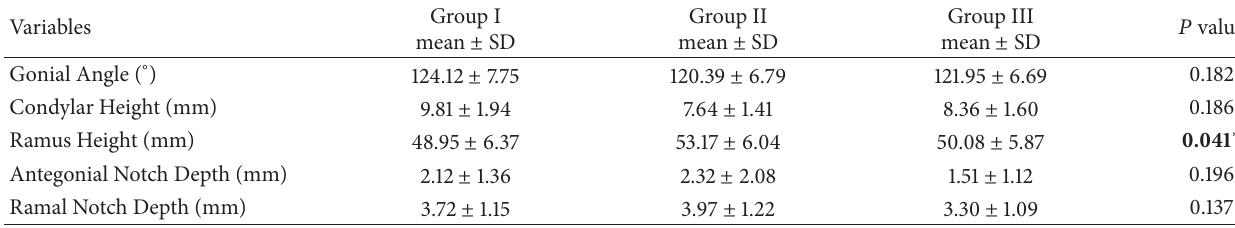
Table 2: Comparison of variables with Kruskal-Wallis test related to groups.